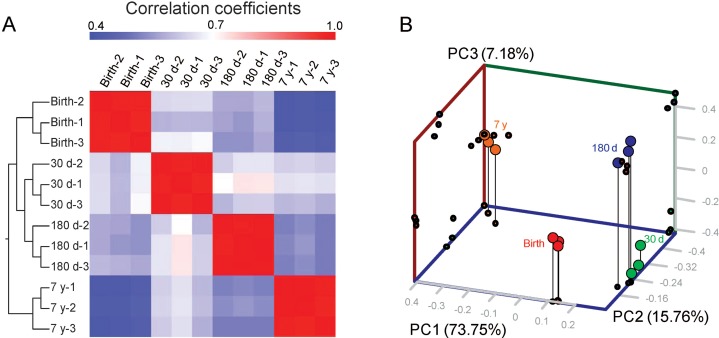
Analysis of samples.(A) Heat map matrix of Pearson’s correlation among samples. (B) Three-way PCA plot of samples. The fraction of the variance explained is 73.75%, 15.76% and 7.18% for eigenvector 1, 2 and 3.